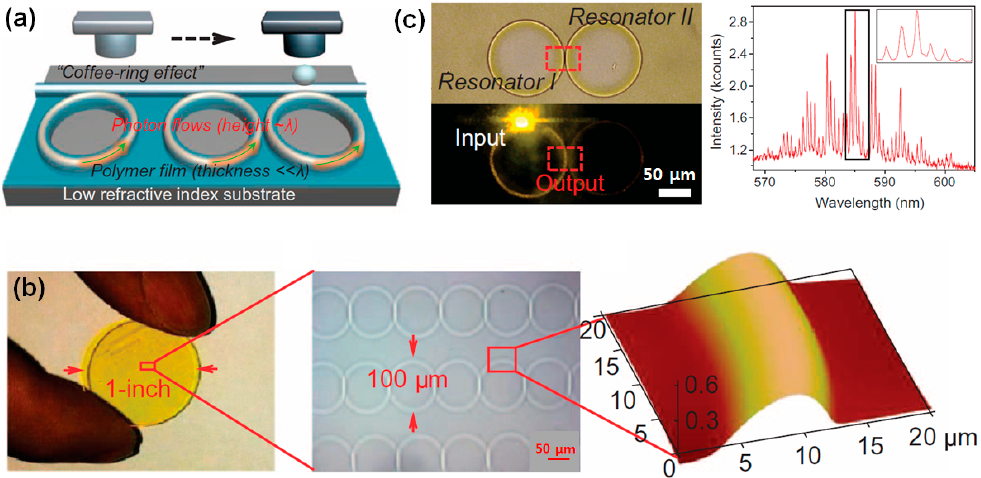
Figure 5. ( a ) Schematic representation of the fabrication of a photonic circuit with inkjet printing. ( b ) Photograph of a photonic circuit with a uniform pattern. An optical microscopy image and an atomic force microscopy (AFM) image of the photonic circuit are shown in the middle and right hand columns, respectively. ( c ) Optical microscopy image of coupled resonators with two rings at a distance of 500 nm and the corresponding spectrum [30]. Copyright 2015 American Association for the Advancement of Science.